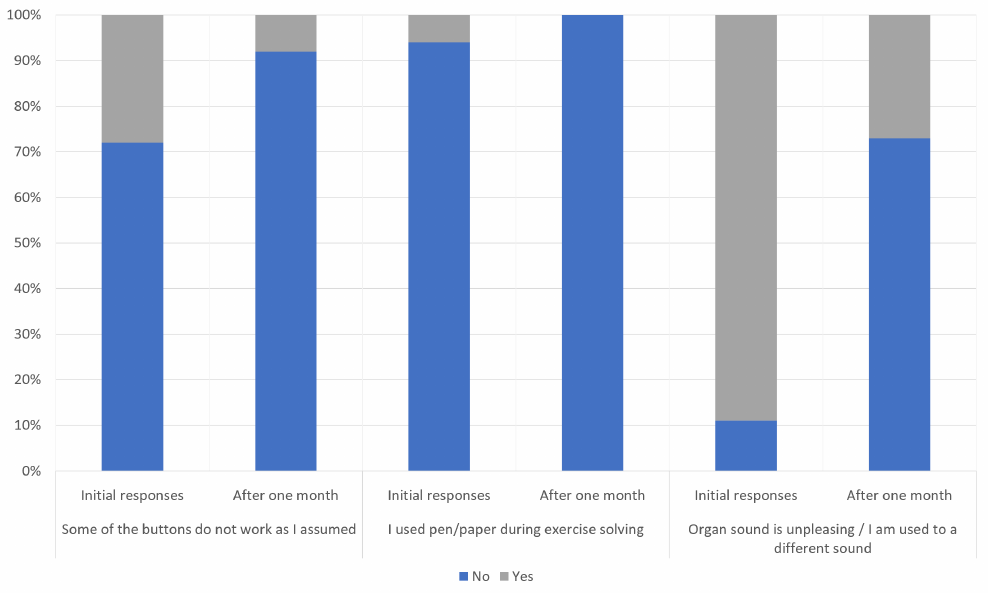
Figure 7. Initial responses to individual questions about the students’ behaviour and experience while using the application, and the responses after one month of application’s use. The most significant change is in the students’ perception of the organ sound. No student reported still using pen/paper while using the rhythmic application.